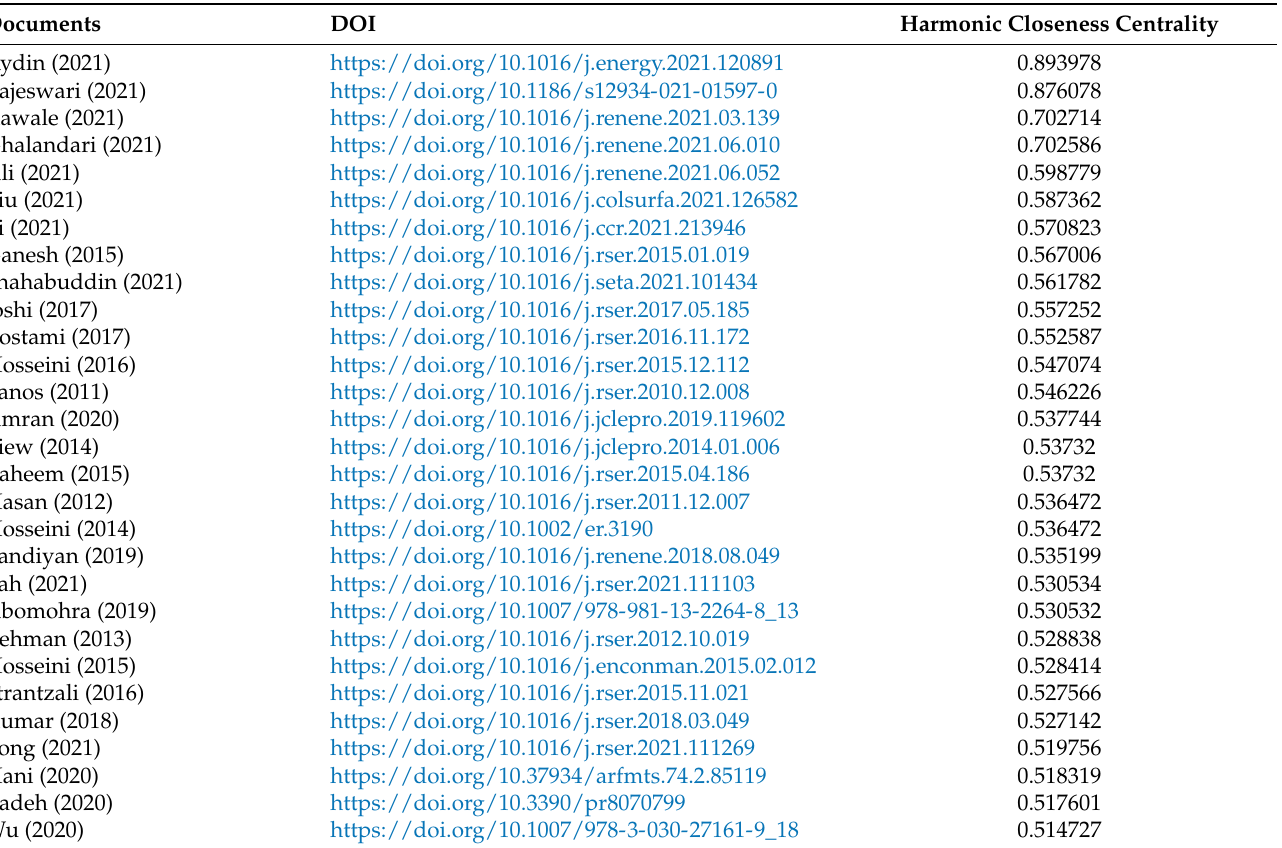
Table 7. Top documents with higher harmonic closeness centrality from Scopus and WoS top-20 documents, after removing duplicates, for bibliographic coupling